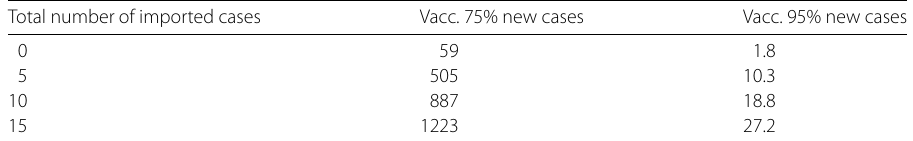
Table 2 Model output for infection